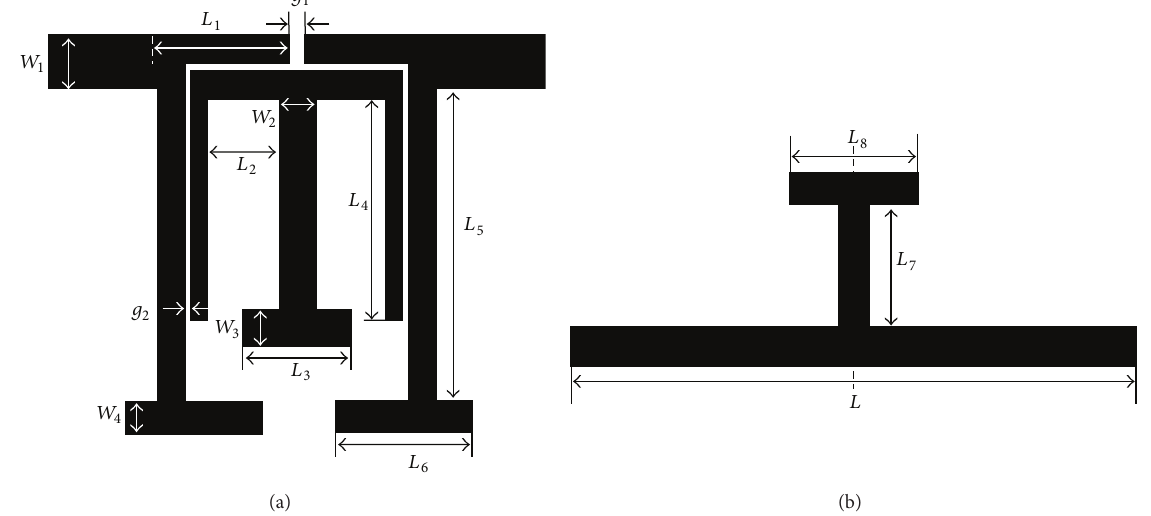
Figure 1: (a) Layout of the dual-mode BPF and (b) schematic view of the proposed TSSLR.